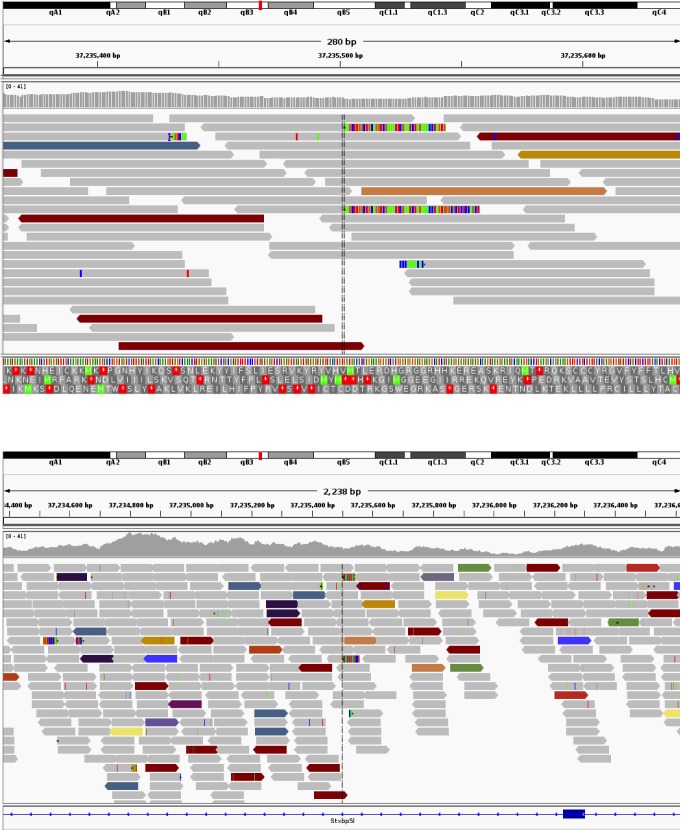
Transgene integration site for F38.Adapted from the screenshots from the IGV genome viewer show the integration sites of the transgene in chromosome 16. The colored reads indicate that the other half of the fragment maps discordantly. The teal colored reads are those that have mates on the transgene, and the purple reads (asterisked) on chr17 (the homologous segments to the transgene material, which are ambiguous for mapping purposes). Multi-colored segments at the ends of reads highlight soft-clipped portions of reads. There is a singular soft-clip for the two sites (entry and exit) of the integration in sample F38.